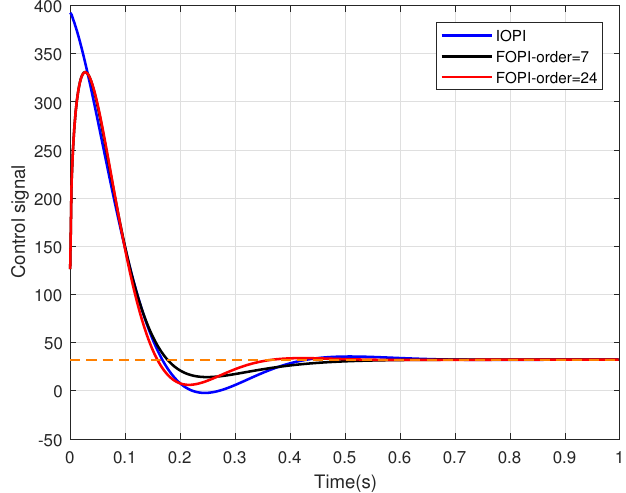
Figure 14. The controllers output signals.